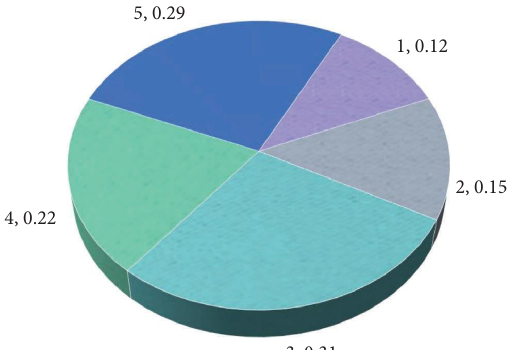
Figure 5: Data packet loss rate.